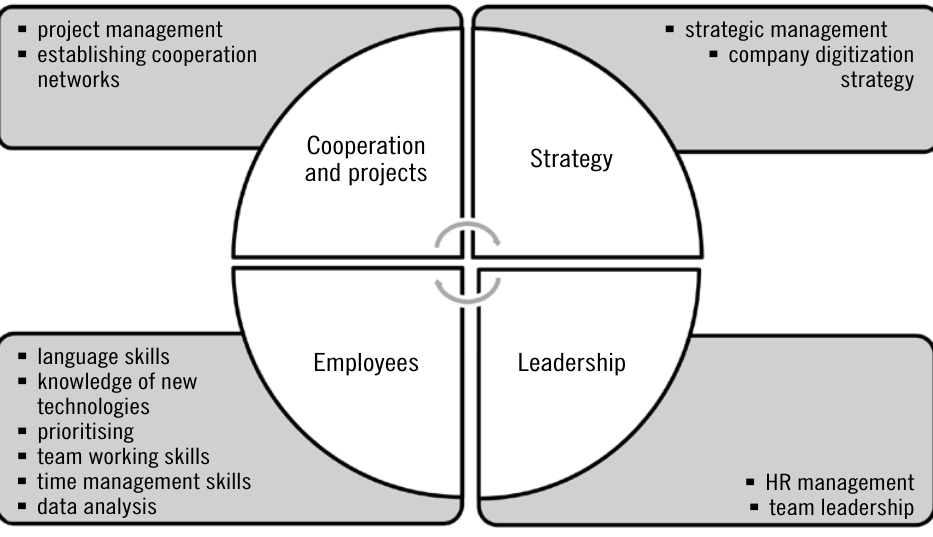
Source: own elaboration of Nosalska et al.